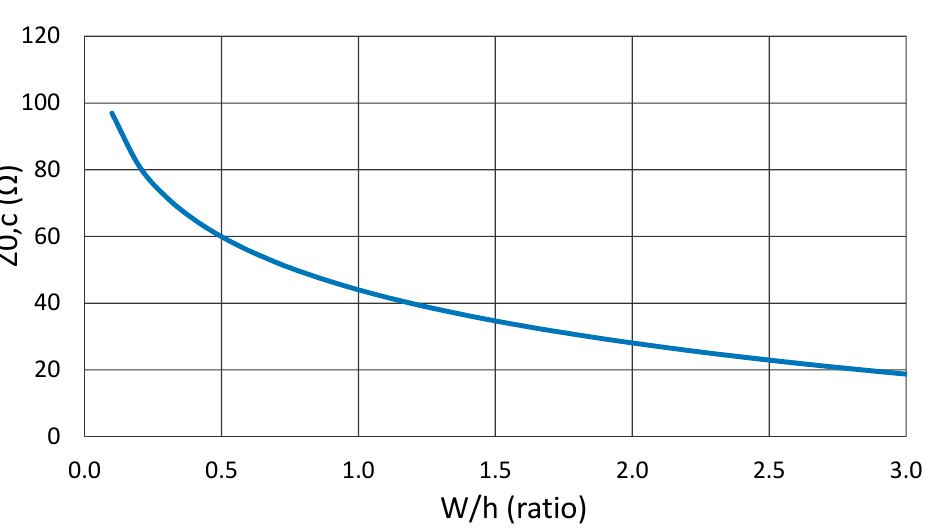
Figure 5. Characteristic impedance vs. W / h ratio for a GaAs or InP microstrip line at millimeter-wave frequencies.